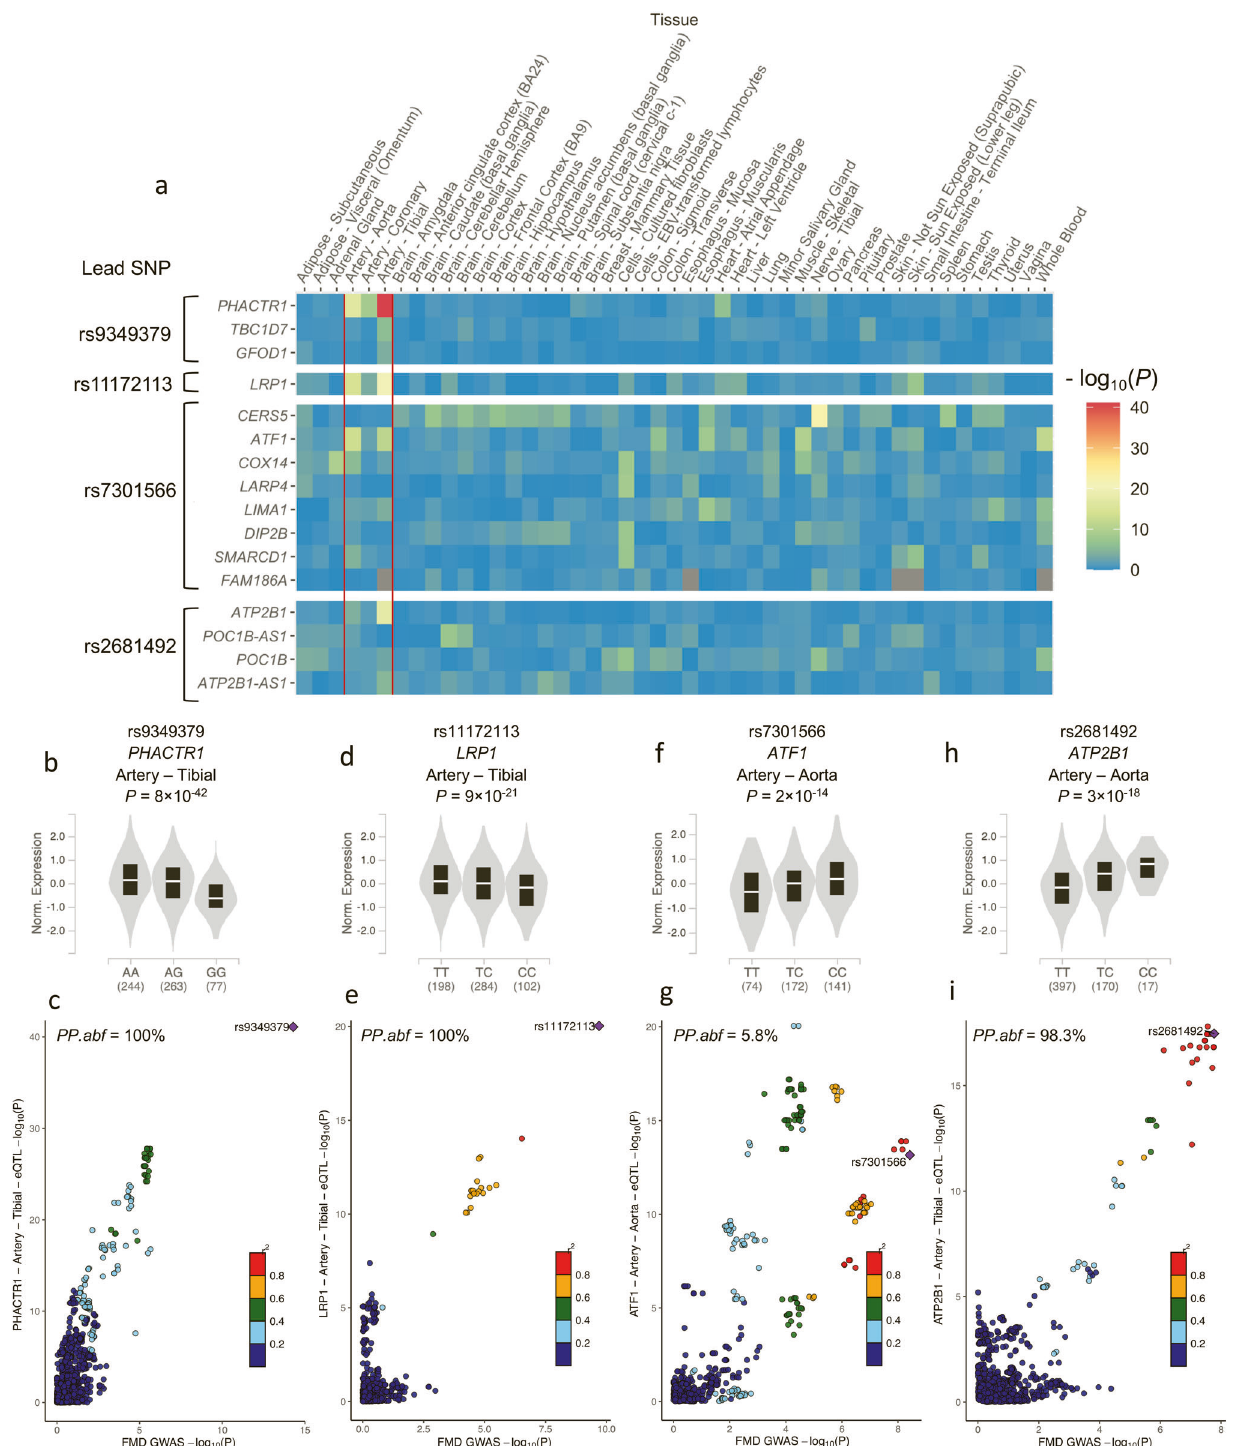
Fig. 2 Tissue-wide eQTL signals near FMD loci. a Heatmap representation of eQTL signals at FMD loci. GTEx v8 database was queried for signi fi cant eQTLs using the lead variant rsID number. All genes identi fi ed as positive eQTL in at least one tissue were selected to calculate eQTL associations in all tissues available in this database. The negative logarithms ( − log 10 ) of the eQTL association P values are represented in a blue – red colour scale. b , d , f , h Violin plots representing normalized expression of PHACTR1 ( b ), LRP1 ( d ), ATF1 ( f ) and ATP2B1 ( h ) by genotype of lead SNPs in tibial artery ( b , d , h ) and aortic tissue ( f ). Plots illustrate the best eQTL association in arterial tissue for the lead SNP at each locus. eQTL unadjusted P values were obtained from testing that the slope of linear regression model between genotype and expression deviates from 0 using a two-sided Wald test. FMD risk allele is on the left. c , e , g , i Colocalization plot of FMD association ( x -axis, log scale of genetic association P value) with tibial artery ( c , e , i ) and aortic tissue ( g ) eQTL association ( y -axis, log scale of P value) at each locus. Dot colour represents the LD r 2 with the lead variant in 1000G European samples. FMD lead variant is highlighted (Diamond shape, purple). Approximate Bayes Factor Posterior Probability ( PP.abf ) for the two traits to share a common causal variant (H4 coef fi cient) is